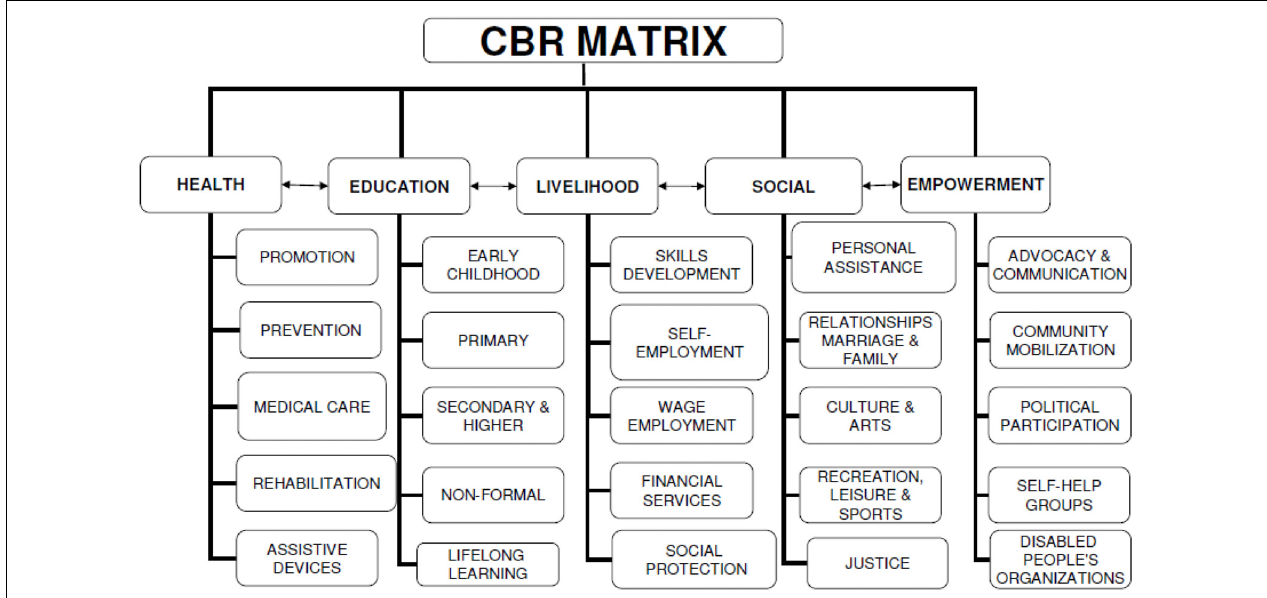
FIGURE 8 | Areas of CBR activities (WHO, 2010: https://www.who.int/disabilities/cbr/matrix/en/).